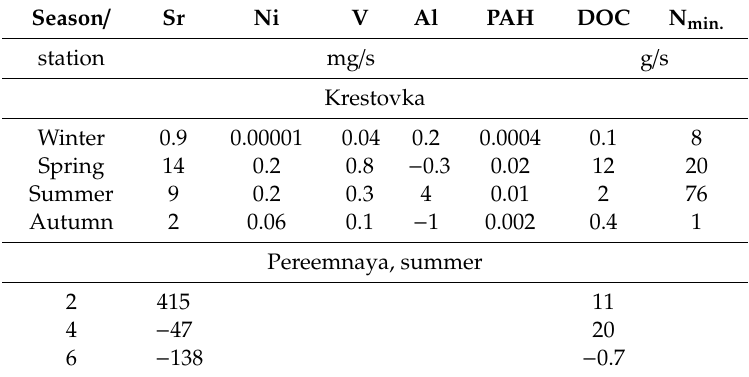
Table 5. Rates of contaminant removal from the small tributaries of Lake